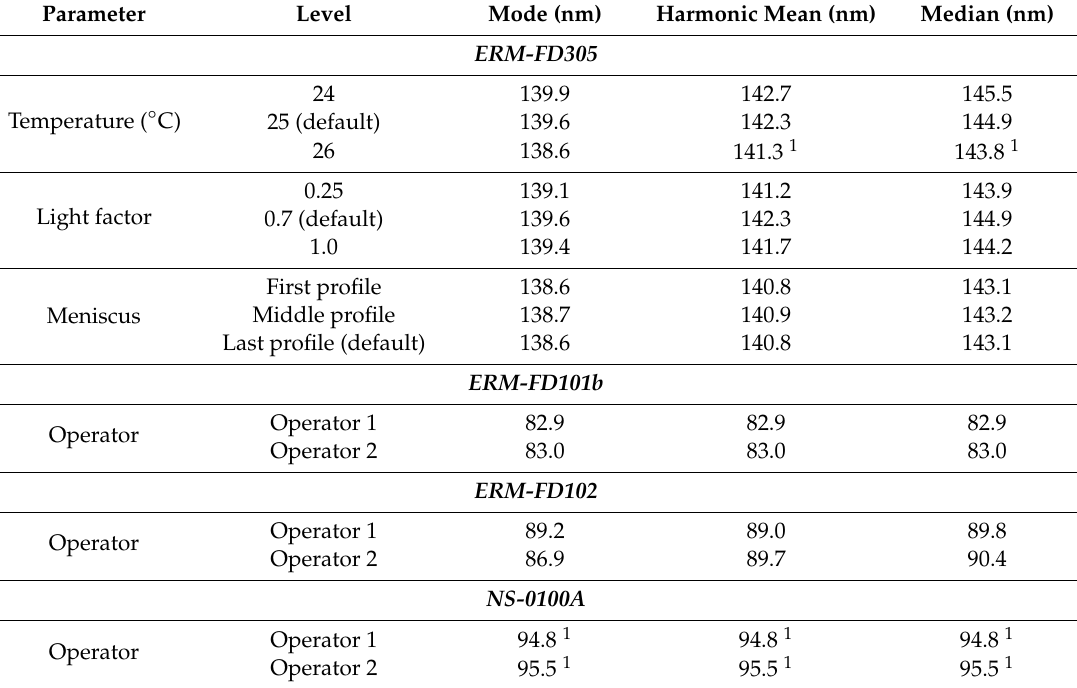
Table 6. Results of robustness testing